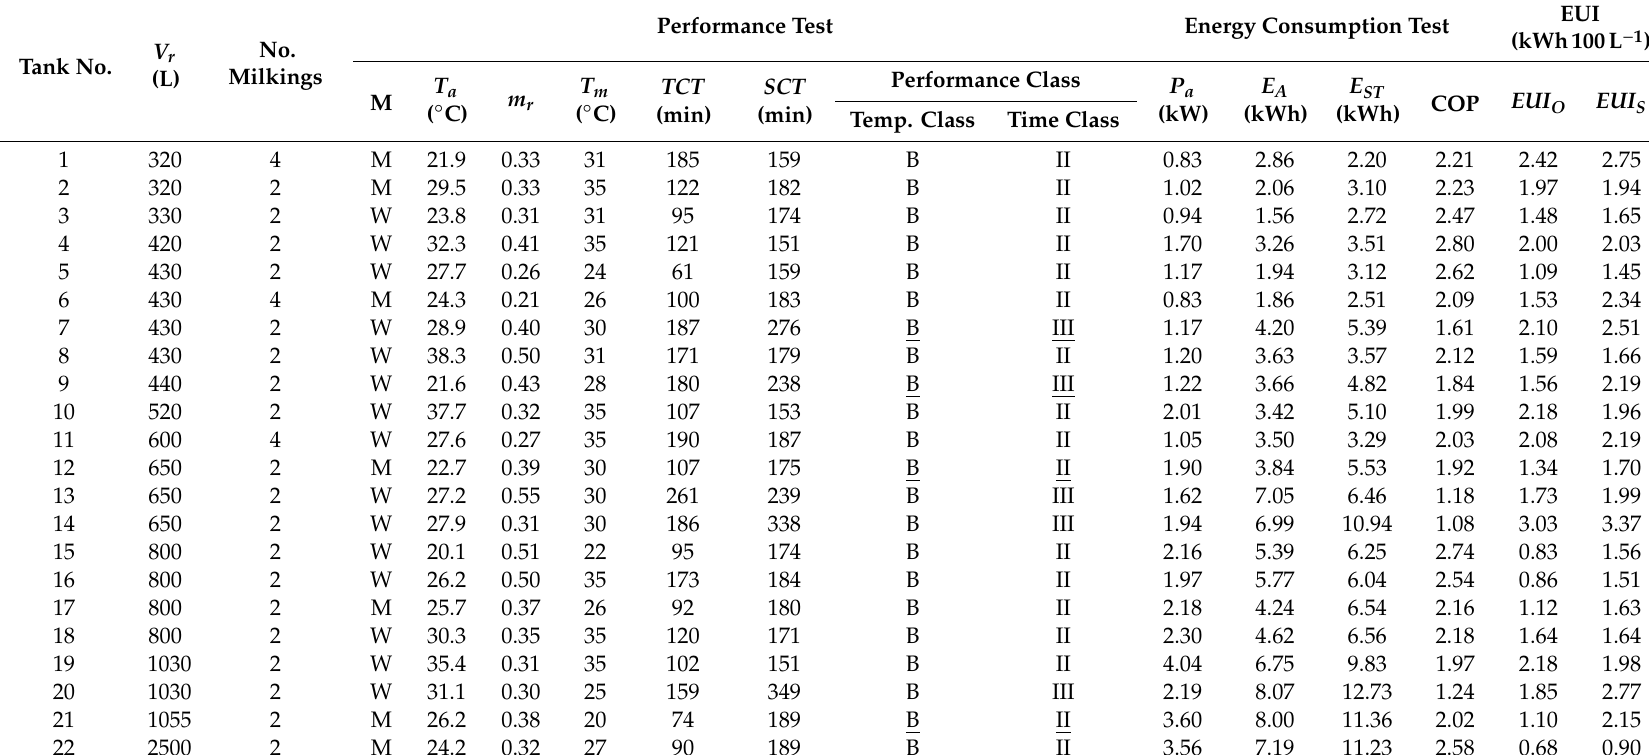
Table 3. Main results of the performance and the energy consumption tests. The Energy Utilization Index (EUI) observed under both operating ( EUI O ) and standard ( EUI S ) conditions is reported. M represents the medium used for the test (M for milk or W for water). Tanks with a standard cooling time ( SCT ) beyond III class limits were classified as malfunctioning (MCS Nos. 7-9-13-14-20), whereas the underlined performance classes are referred to tanks with no available / readable identification plates that were classified after the